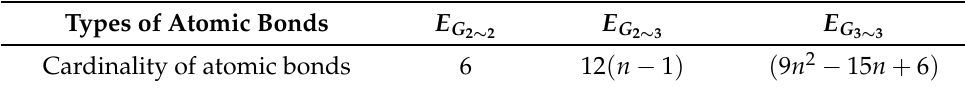
Table 5. Atomic bond partition of HB n